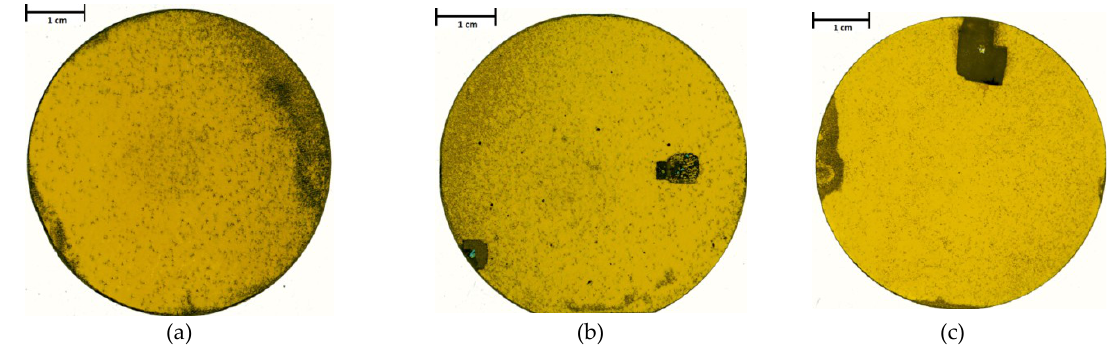
Figure 2. Through-Light optical scans of three free-standing 3C-SiC two inch wafers with an as-grown thickness of ( a ) 0.87 mm, ( b ) 0.78 mm, and ( c ) 0.5 mm. All three crystals were polished on both sides. Samples ( b ) and ( c ) feature burst areas.